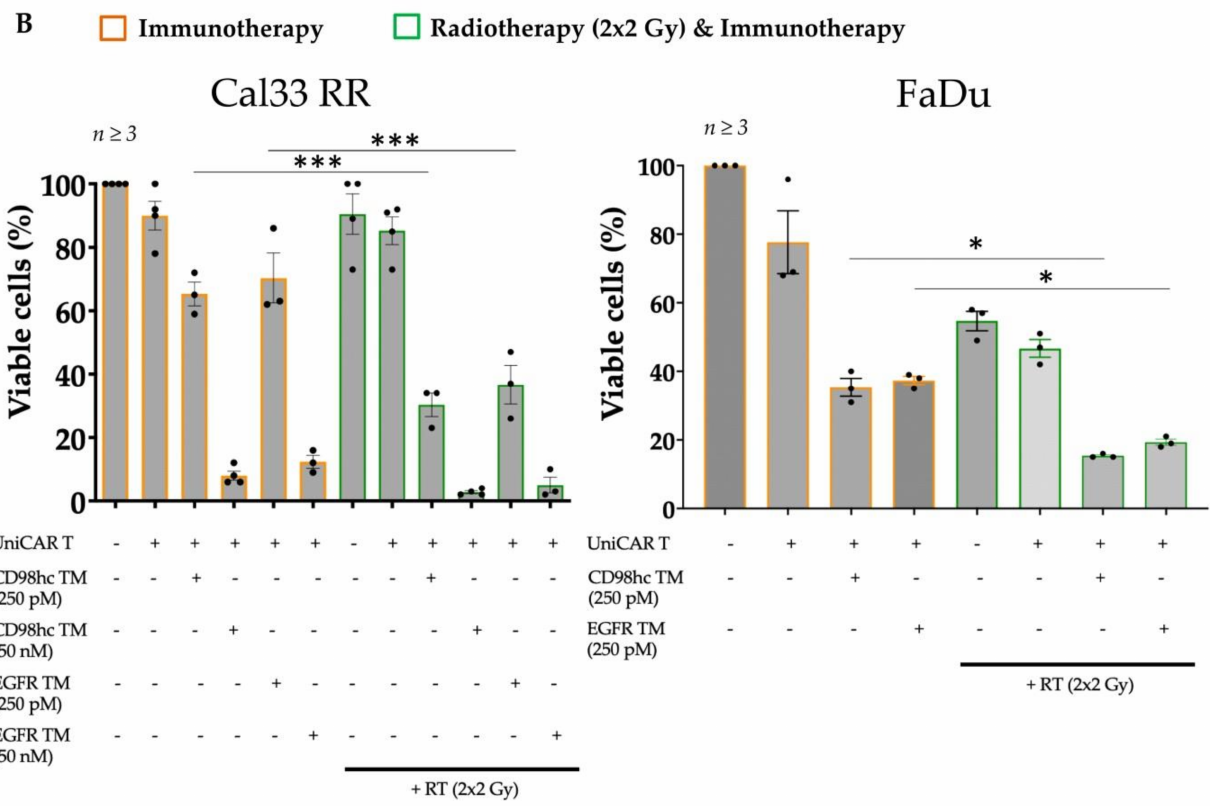
Figure 4. The combination of RT with immunotherapy has a synergistic effect. ( A ) Scheme, and timeline of procedures for combination therapy. Created with https://biorender.com, accessed on 31 January 2022. Upon spheroid formation, spheroids were given 2 × 2 Gy fractionated irradiation in 2 consecutive days. 6 h after final fraction, UniCAR T treatment was performed in the presence or absence of CD98hc TM. 48 h after treatment, viable cell percentages were analyzed by flow cytometry. ( B ) RT in combination with CD98-redirected UniCAR T treatment was significantly more efficient in eliminating Cal33 RR and FaDu spheroids than immunotherapy or RT alone. Experiments were performed in triplicates. One-way ANOVA with post hoc Tukey multiple comparison test was applied to calculate the statistical significance of the treatment efficacy (treated vs. control spheroids); error bars, mean ± SEM. * p < 0.05, *** p < 0.001. All calculated p -values are shown in Figure